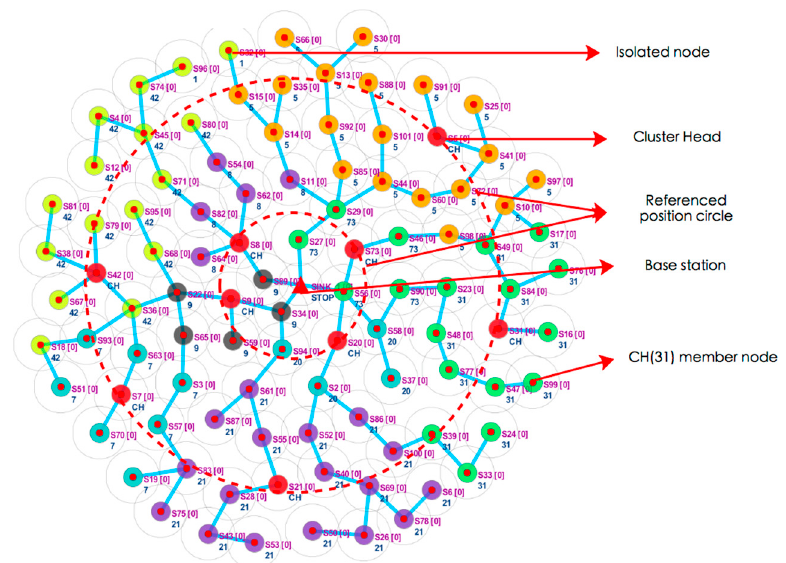
Figure 4. Cupcarbon simulation of FTUC. Cluster heads are evenly distributed in the network, and unequal clusters are created.